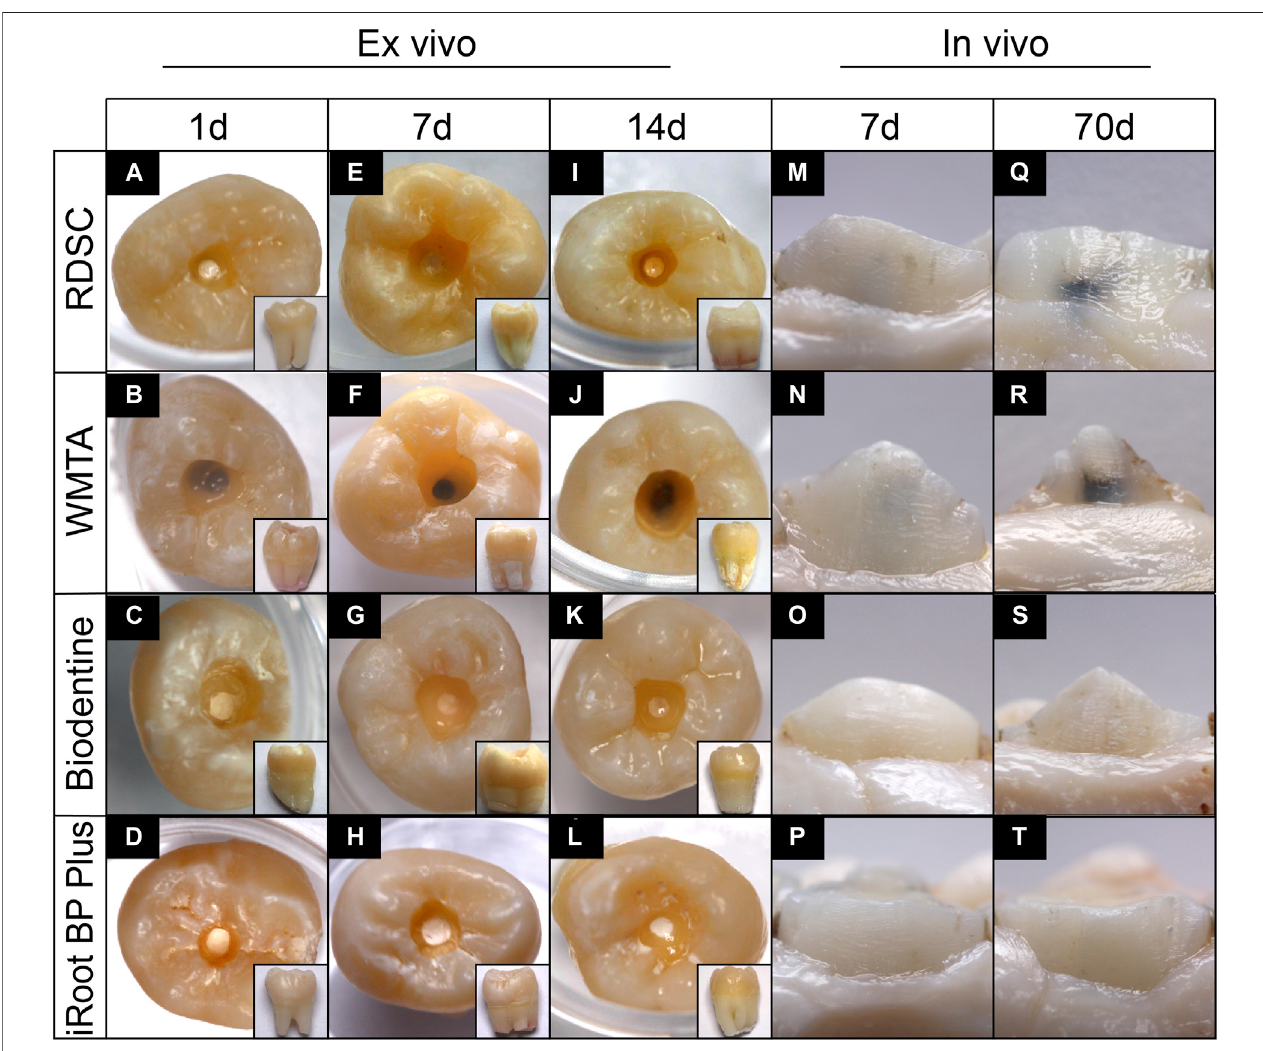
FIGURE 4 | Color stability assessment in ex-vivo human tooth culture model and in-vivo miniature pig model. Teeth were capped for 1, 7 or 14-days ex-vivo (A – L) and 7 or 70 days in-vivo (M – T) .